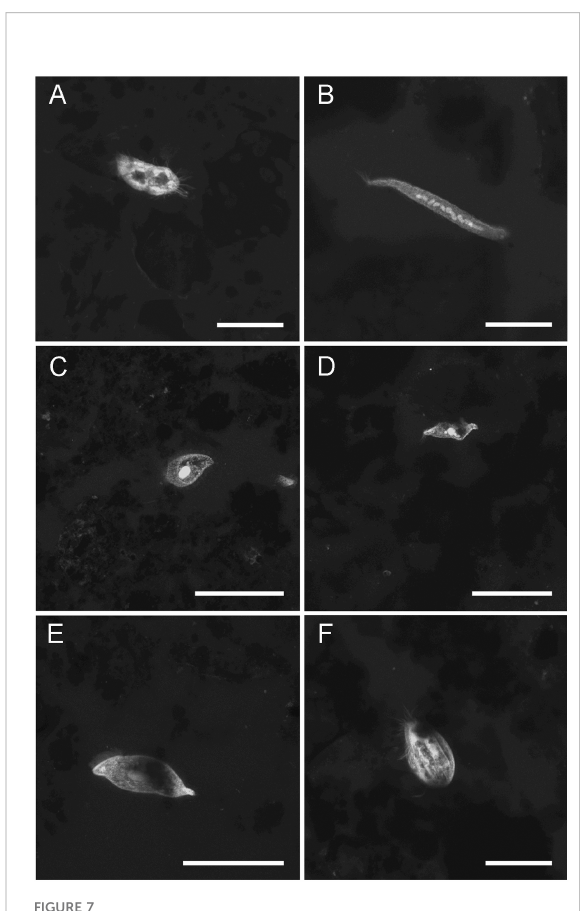
FIGURE 7 LSCM images (z-stacks) of ciliate protists. (A) Core 16 (inside caldera removed from chimney), 4mm depth. (B) Elongated ciliate with moniliform macronucelus, Core 18 (chimney base), 0.5mm depth. (C) Core 19 (chimney base), 1.5mm depth. (D) Specimen similar to those in Figure 4C, Core 18 (chimney base), 1mm depth (E) Core 17 (chimney base), ~0.5mm depth. (F) Core 17 (chimney base), 3mm depth. Number of images compiled/distance between images (µm): (A) =27/0.3; (B) = 28/ 0.3; (C) = 25/0.7; (D) = 31/0.7; (E) = 140/0.5; (F) = 75/0.3. Scales: (A, B, F) = 50 µm; (C – E) = 100